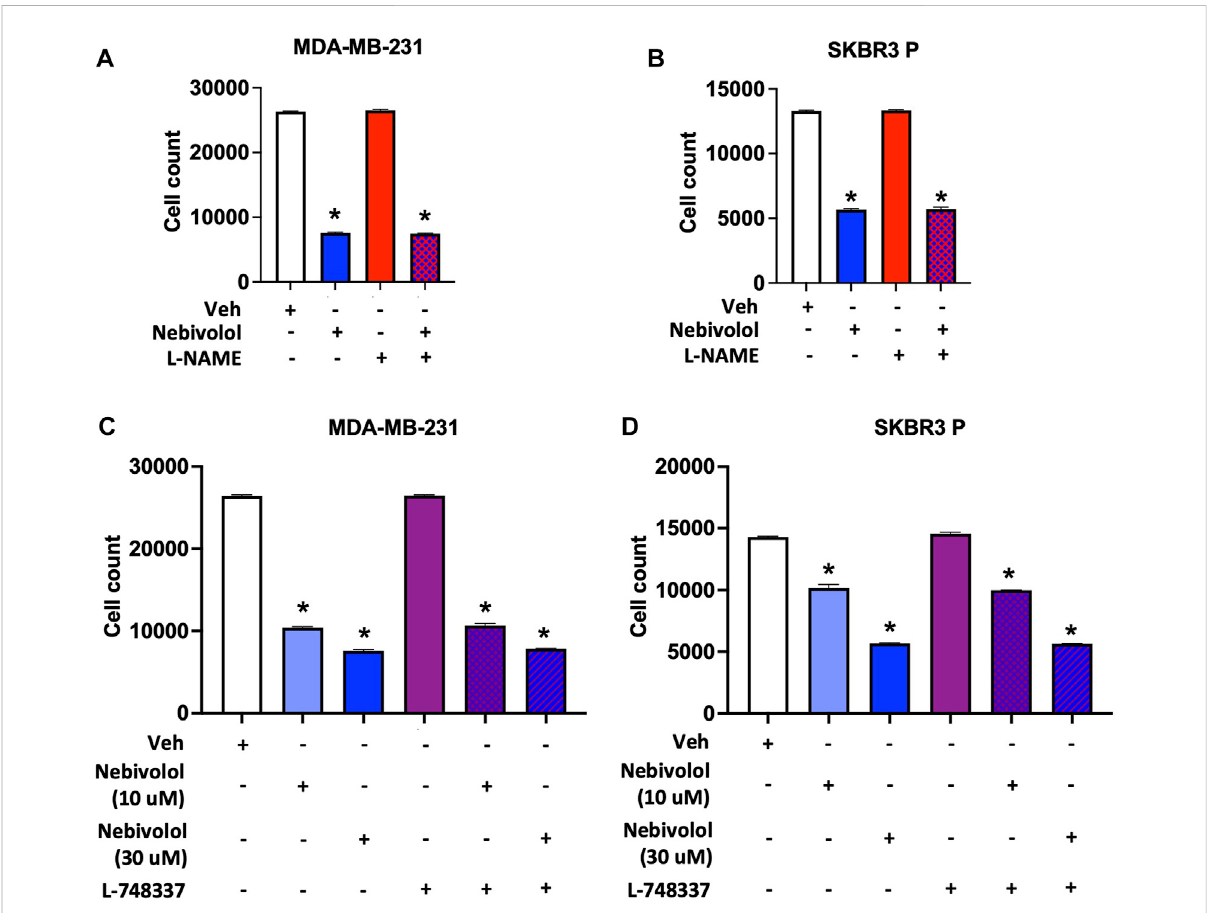
FIGURE 2 Nitricoxide(NO)synthaseinhibitor(L-NAME)and β 3antagonist(L-748337) donotaffectnebivolol-inducedinhibitionofcellgrowthinBCcells. Effects of L-NAME (1 mM) on nebivolol (10 µM)-induced inhibition of cell growth measured by the cell count in (A) MDA-MB-231 and (B) SKBR3 P cells.EffectsofL-748337(7 µM)onnebivolol(10 µMor30 µM)-inducedinhibitionofcellgrowthmeasuredbythecellcountin (C) MDA-MB-231and (D) SKBR3 P cells. * indicates statistically signi fi cant difference compared to Veh; p < 0.05 by unpaired t -test ( n =